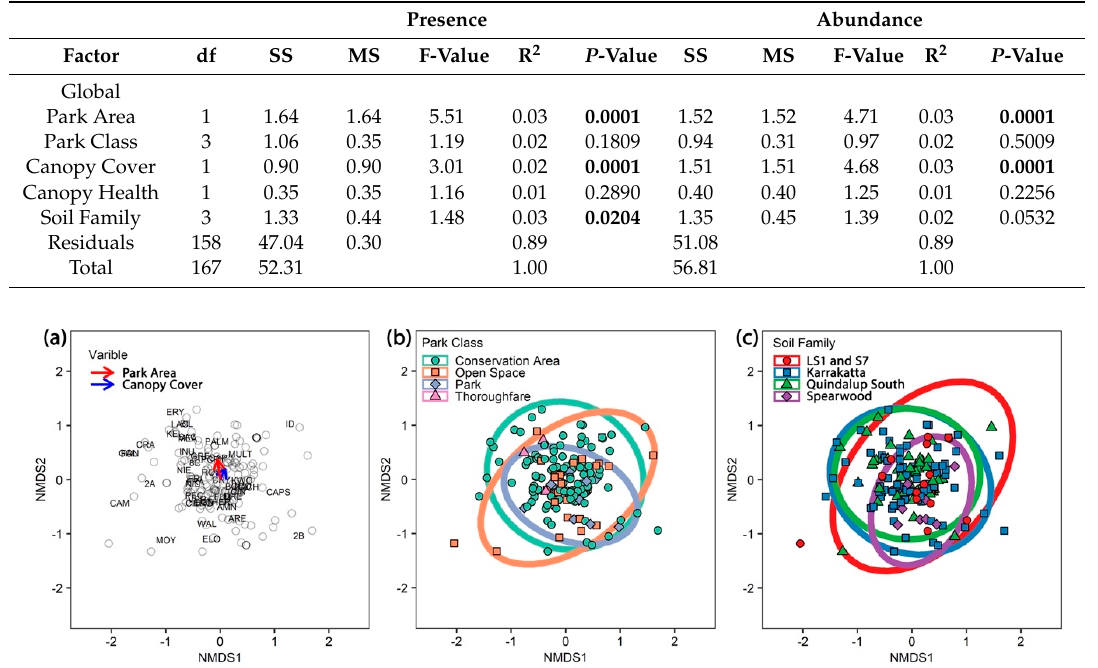
Figure 3. ( a ) Non-metric multidimensional scaling (NMDS) plot showing the significant continuous variables park area and canopy cover. Phytophthora species codes and site (hollow points) are displayed on the plot. The arrow length is proportional to the degree of correlations between the variable and the ordination. The arrows are very short indicating minimal correlation. ( b , c ) NMDS plots of Phytophthora communities showing the complete overlap of ellipses for ( b ) park class, and ( c ) soil family.